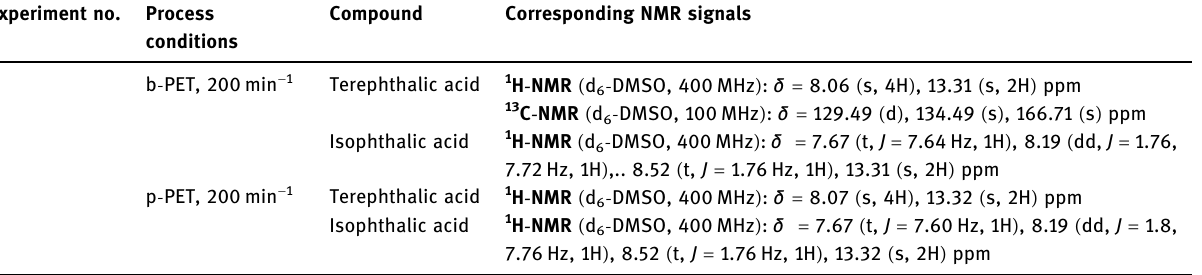
Experiment no. Process